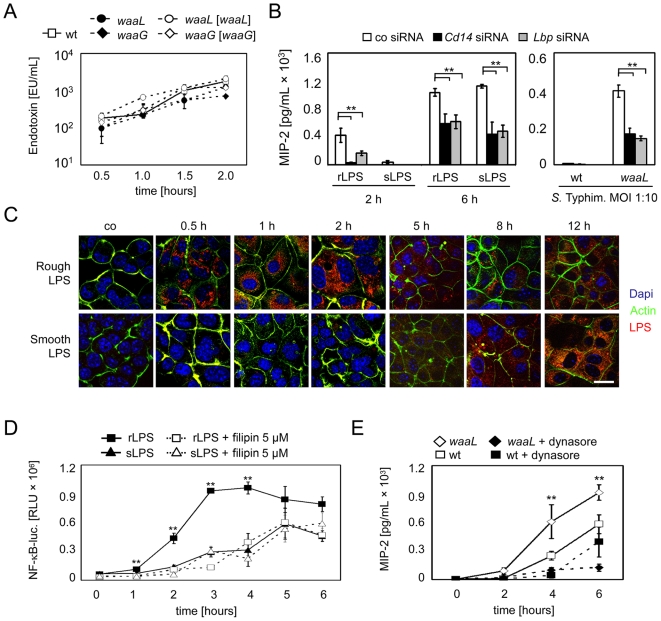
Delayed recognition of wildtype LPS is associated with reduced internalization.(A) Endotoxin released in the cell culture medium from wildtype S. Typhimurium, two isogenic O-antigen deficient mutants (waaL and waaG), as well as their respective complemented controls at a concentration of 106 CFU/mL was quantified using a Limulus assay. (B) MIP-2 secretion by m-ICcl2 cells treated with control-, Cd14-specific, or Lbp-specific siRNA 2 and 6 h after exposure to rough or smooth LPS (10 ng/mL), or 2 h after infection with wildtype and waaL-deficient S. Typhimurium at a MOI of 10∶1. (C) m-ICcl2 cells were exposed to biotin-conjugated rough or smooth LPS for the indicated time points and the internalized LPS was visualized by immunostaining. Counterstaining was performed with MFP488-phalloidin and Dapi. Bar, 5 µm. (D) Stably transfected m-ICcl2 cells expressing a NF-κB-luciferase construct were stimulated with rough (rLPS), or smooth (sLPS) in the absence, or presence of filipin for the indicated time points and the amount of luciferase was quantified. (E) MIP-2 secretion by m-ICcl2 cells exposed to wildtype or waaL-deficient S. Typhimurium in the presence or absence of the dynamin inhibitor dynasore. **, p<0.01.